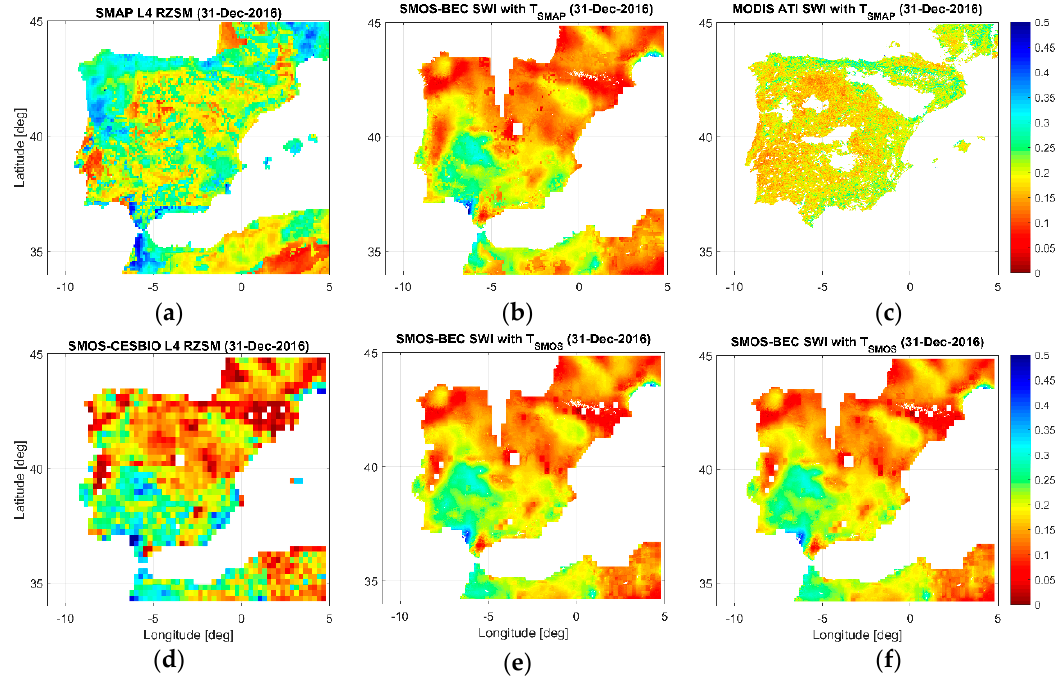
Figure 5. RZSM maps corresponding to a winter day (31 December 2016): ( a ) SMAP L4 RZSM; ( b ) SMOS-BEC SWI (T SMAP ); ( c ) MODIS ATI SWI (T SMAP ); ( d ) SMOS-CESBIO L4 RZSM; ( e ) SMOS-BEC SWI (T SMOS ); and ( f ) MODIS ATI SWI (T SMOS ).